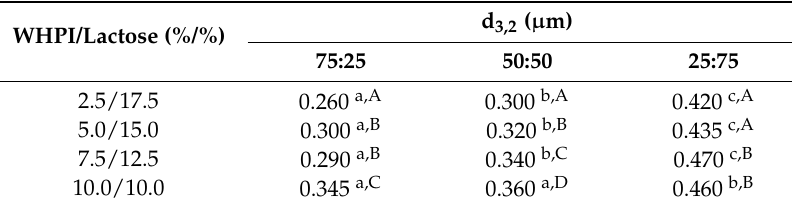
Table 1. The effect of wall composition and wall-to-core ratio on the mean particle sizes (d 3,2 ) of the investigated